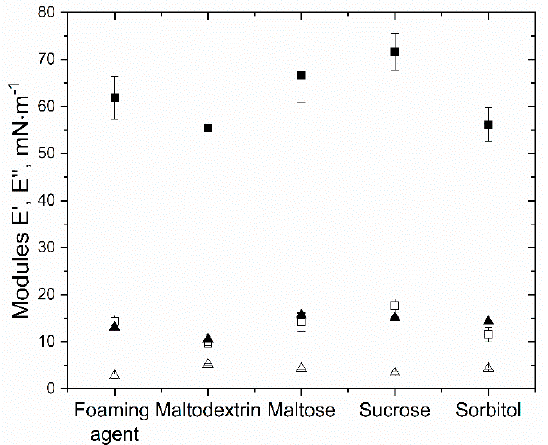
Figure 2. Influence of sugar type on the elastic (E’, squares) and viscoelastic (E”, triangles) moduli of polysorbate (empty symbols) and β -lactoglobulin (filled symbols) samples pure or with a saccharide concentration of 20%. Table 3. Calculated tan ( ϕ ), -for samples with polysorbate 80 or β -lactoglobulin at a saccharide concentration of 20% at 20 ◦ C Foaming Agent